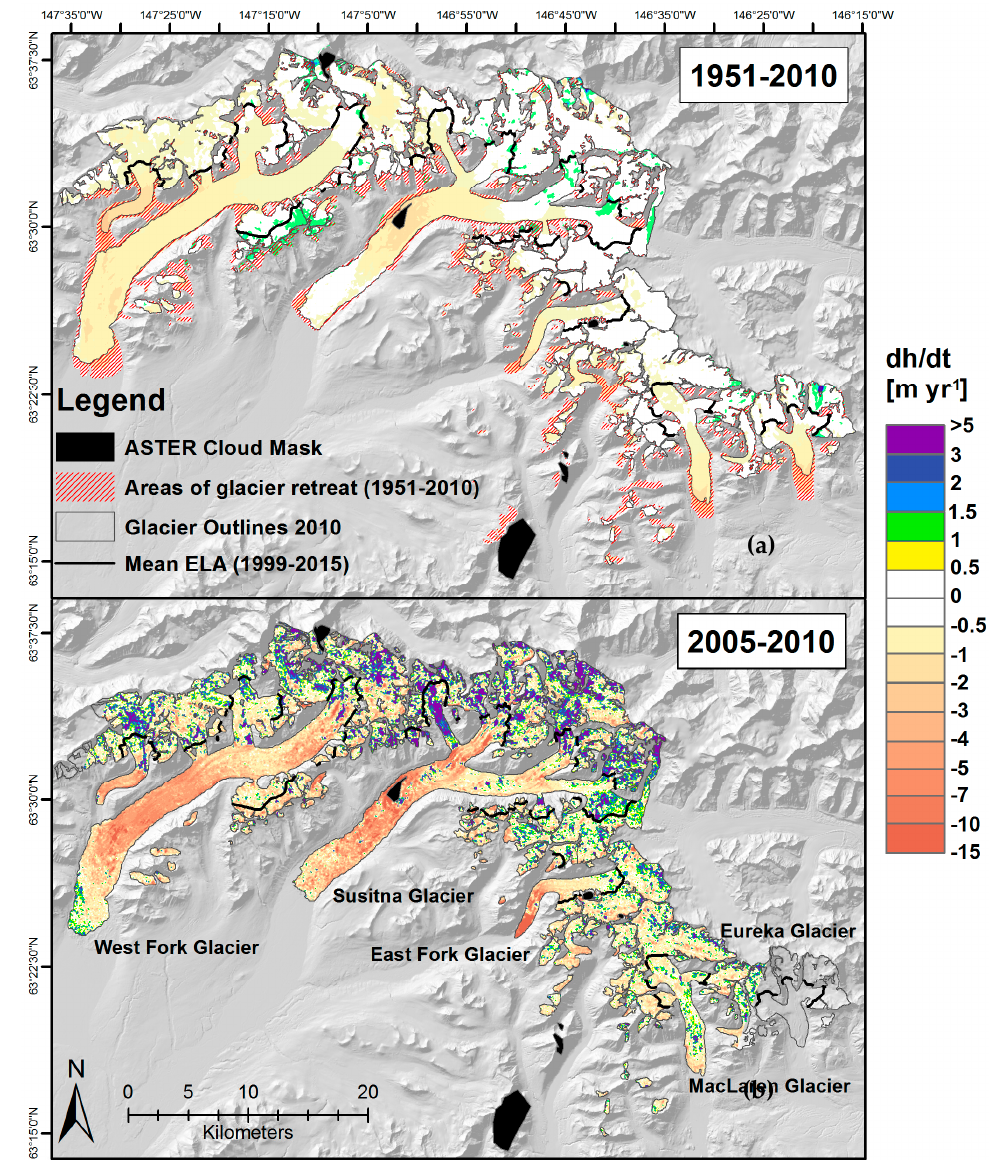
Figure 3. Spatially distributed elevation changes [m yr − 1 ] for the study periods ( a ) 1951–2010 and ( b ) 2005–2010. Hatched areas represent areas that became ice-free between 1951 and 2010 due to glacier retreat. Black areas represent the cloud error mask for the ASTER DEM. The mean equilibrium line for the years 1999–2015 is shown with black solid lines. Note that no elevation changes 2005–2010 are available for Eureka Glacier since the ASTER DEM does not cover the entire glacier.